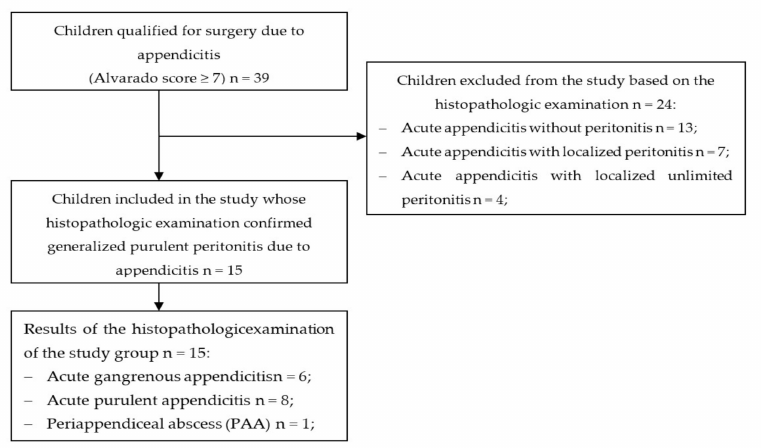
Figure 1. A flow-chart demonstrating the selection of the groups